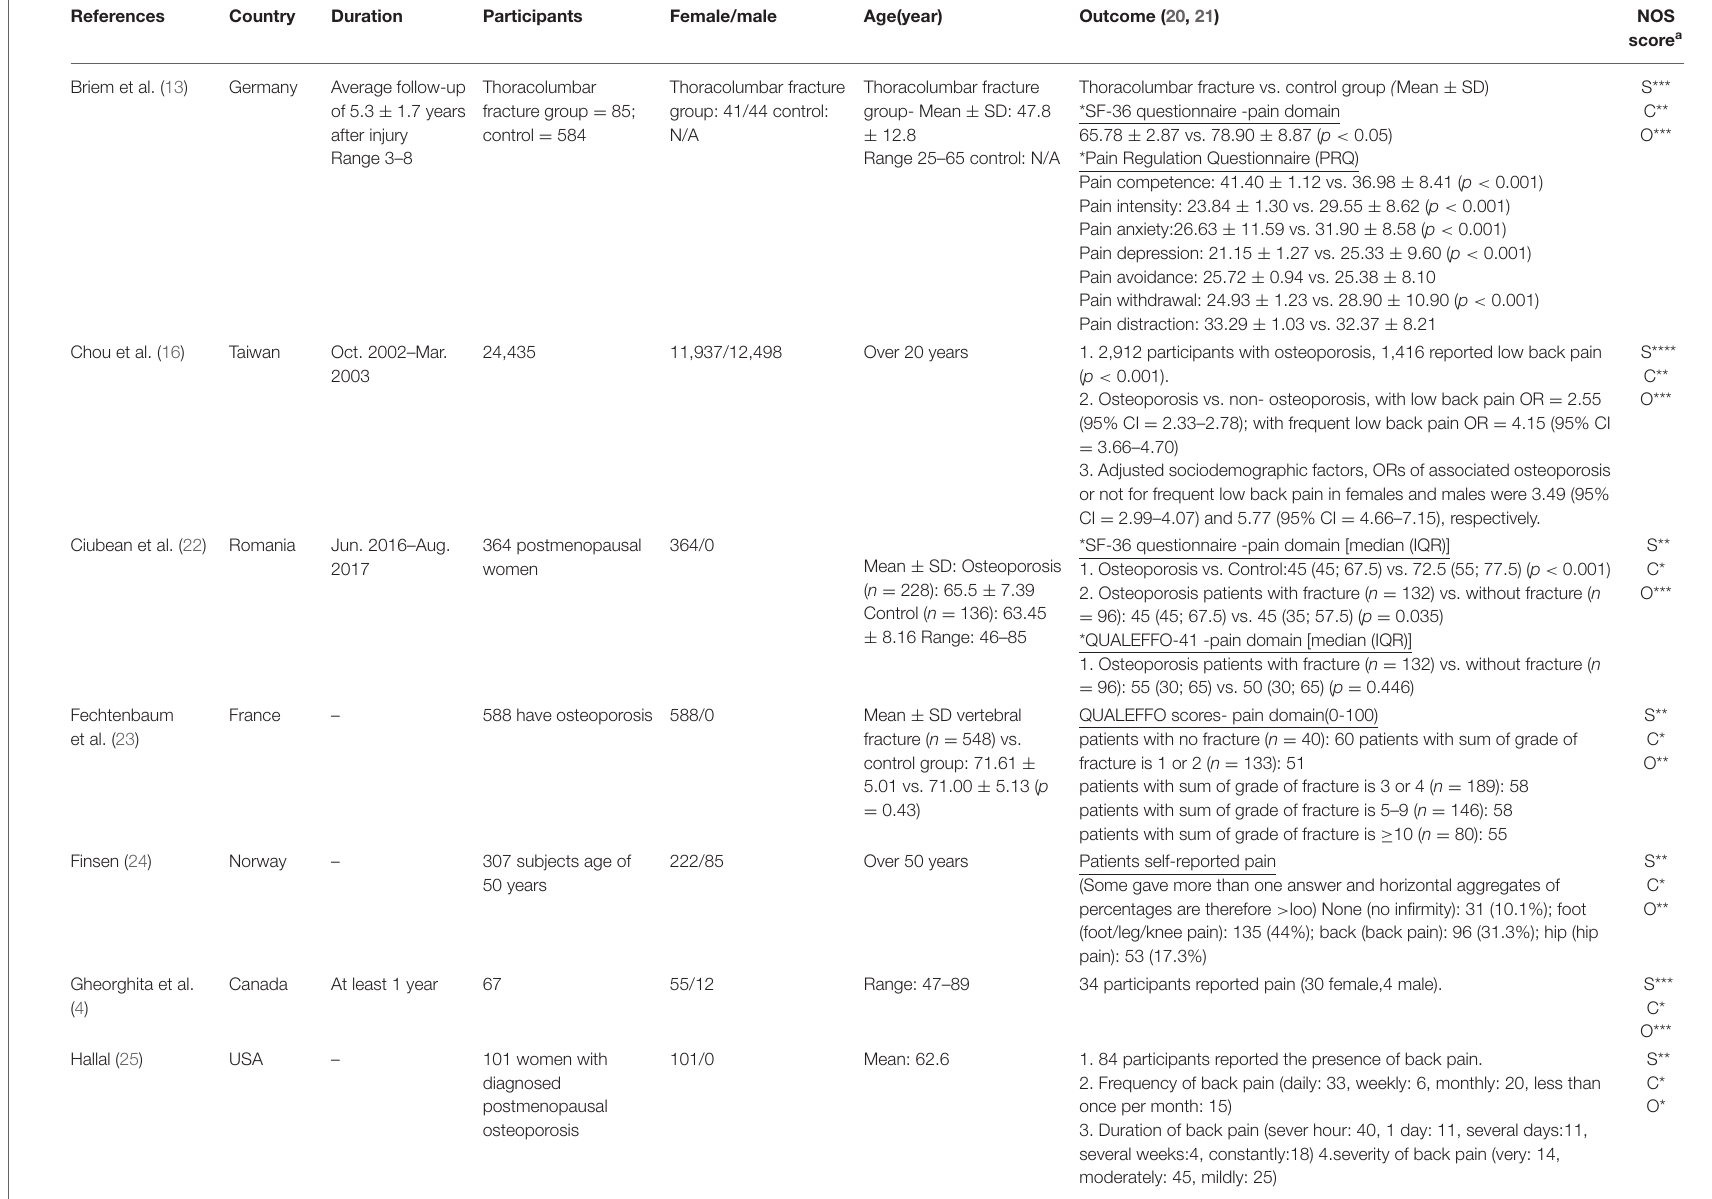
TABLE 2 | Characteristics of included